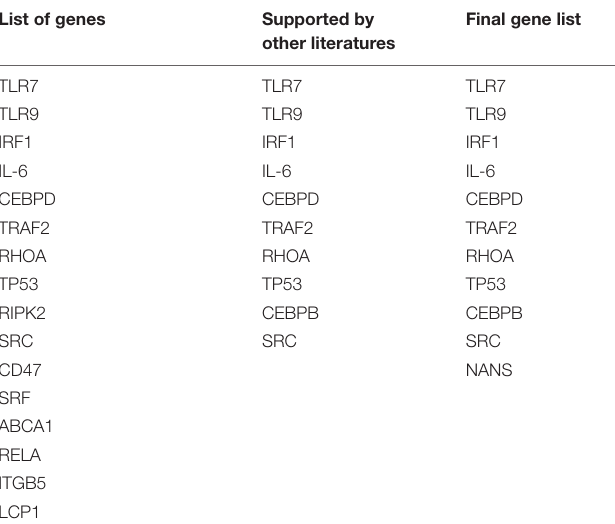
TABLE 1 | Lists of the genes indicated to be significant in bovine coronavirus